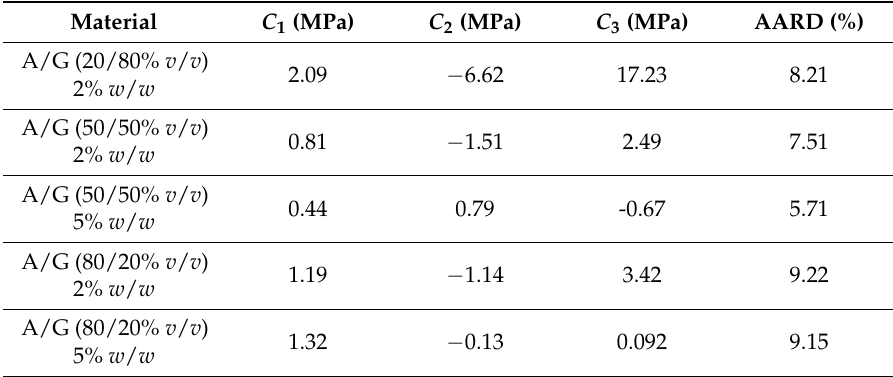
Table 1. Parameters and deviations for the Yeoh